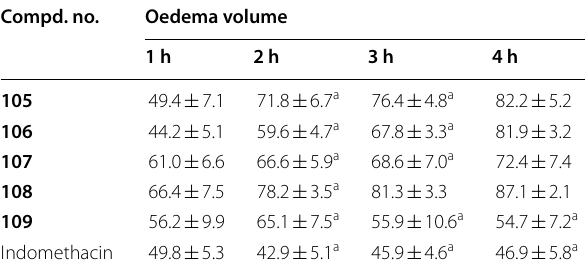
Table 23 Anti-inflammatory effect of synthesized compounds Compd. no.